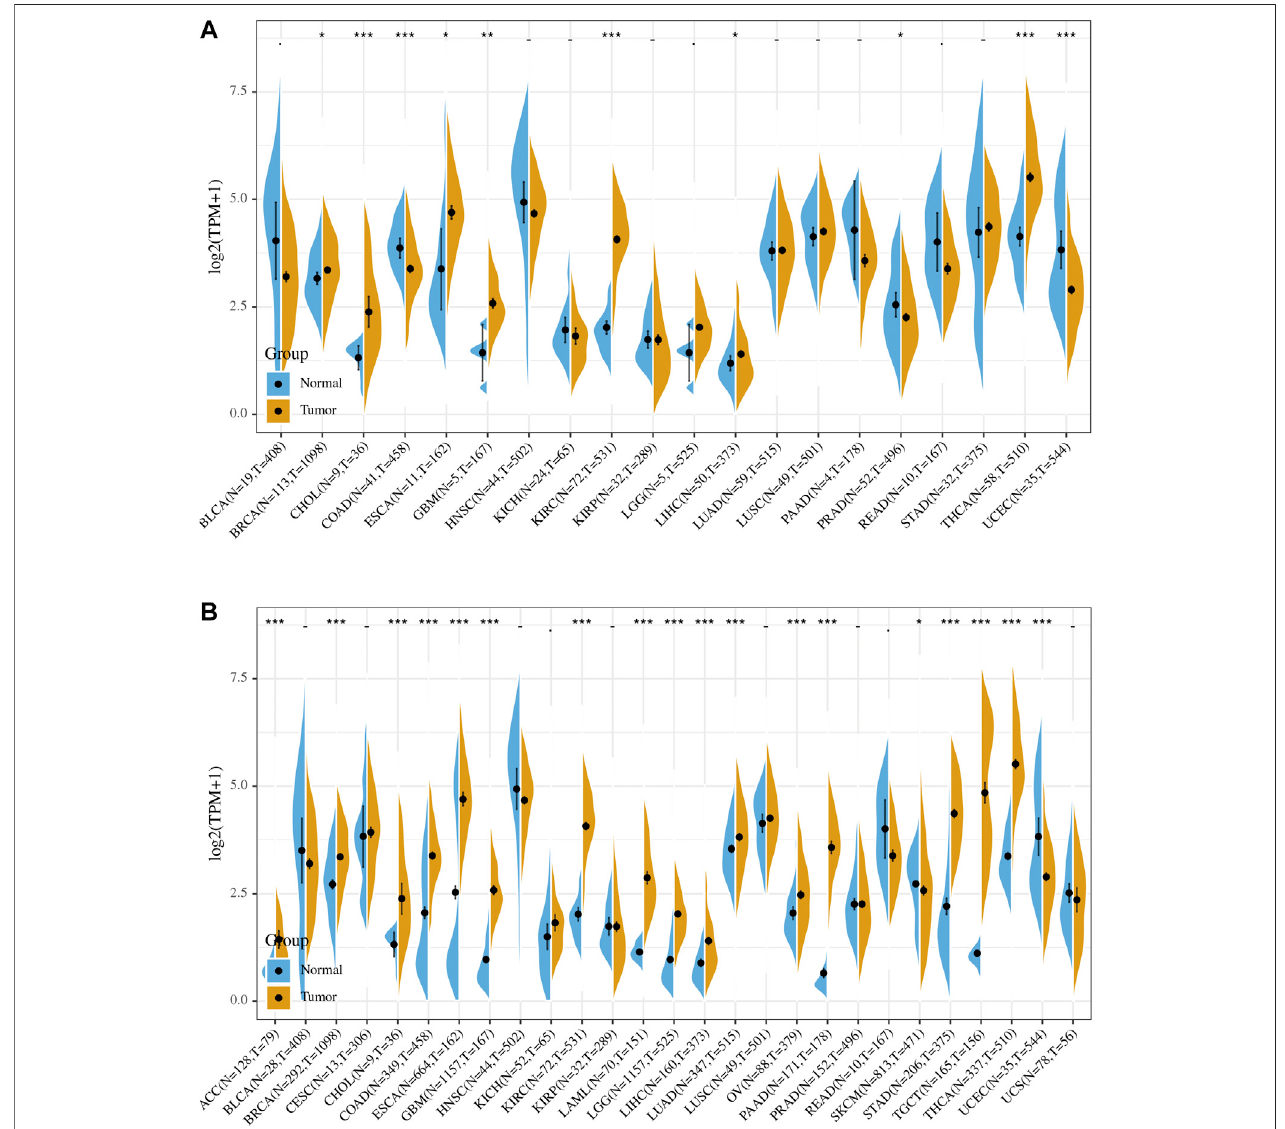
FIGURE 1 | PRDM1 expression levels in different types of human cancers. The expression level of PRDM1 between tumor and normal tissues were compared in twentycancertypesbasedontheTCGAdatabase (A) andtwenty-sevencancertypesbasedontheintegrateddatabasefromTCGAandGTExdatasets (B) .Consistent highexpressionlevelofPRDM1wereobservedintumorsamplesofBRCA,CHOL,ESCA,GBM,KIRC,LIHC,THCAthannormaltissuebasedonbothcomparisons,and signi fi cant increased expression of PRDM1 were also seen in ACC, COAD, LAML, LGG, LUAD, OV, PAAD, STAD, TGCT based on the integrated database.